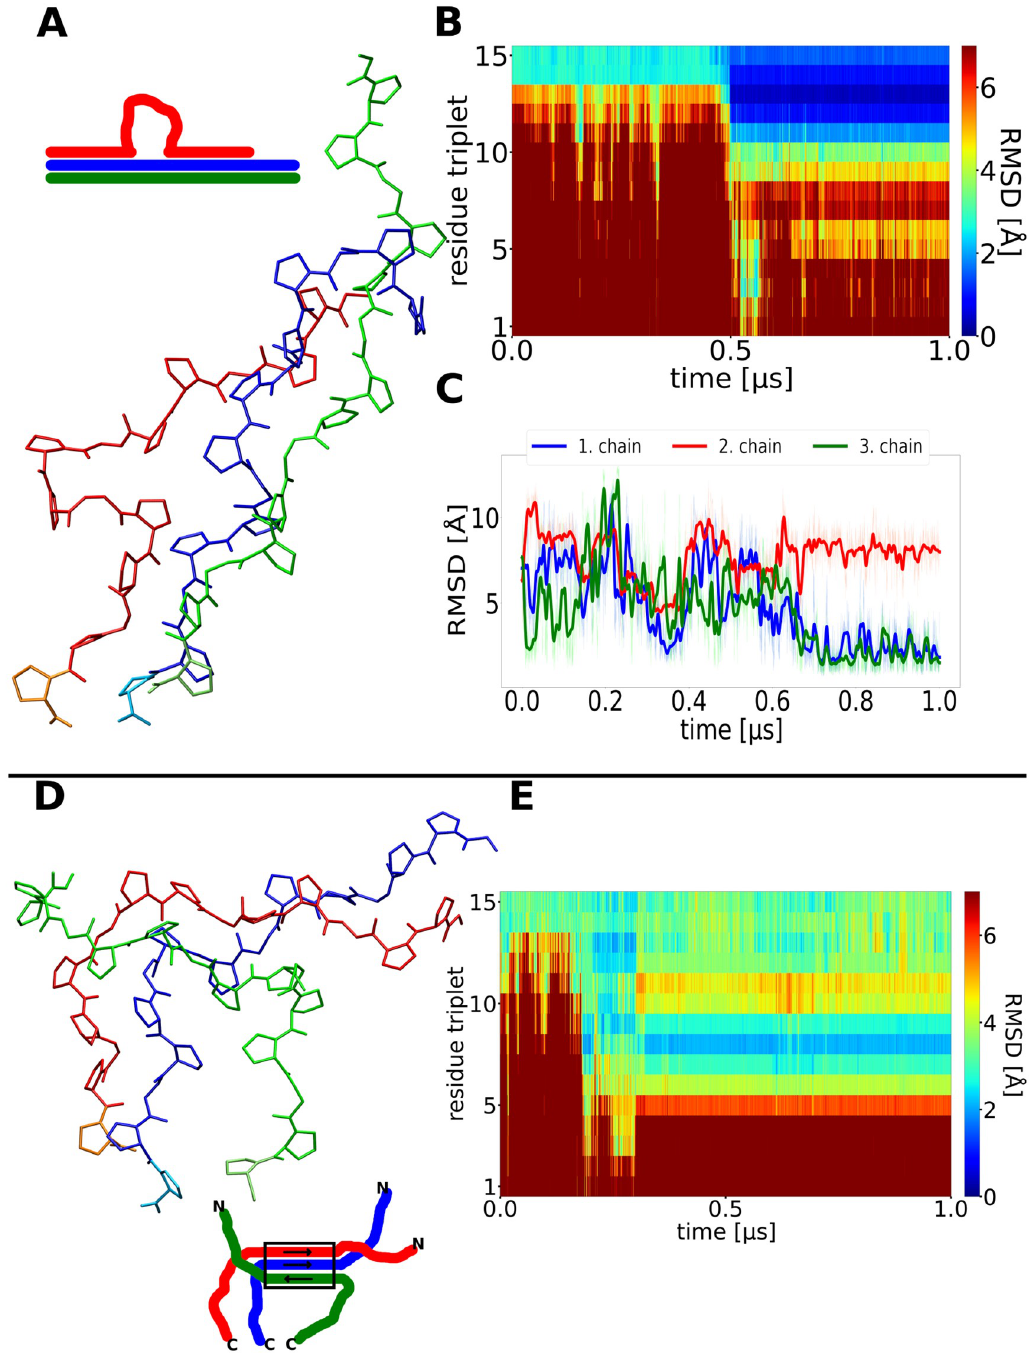
Fig 6. Misfolding of collagen triple helices during simulations (A) Snapshot of a finally sampled conformation with one chain (red) forming a loop but near-native conformation of the neighboring segments observed in a simulation that did not reach the native fold. (B) Time evolution of the RMSD of triplets along the simulation, after 0.5 μ s a correct folding of a first segment up to the loop is observed (blue regime in the plot). (C) RMSD with respect to the native folded triple helix of each chain vs. simulation time. (D) Snapshot at the final stage of a simulation with very weak restraints to stabilize the initial folding nucleus at the C- terminus of the triple helix. The green chain has detached from the other chains at the C-terminus and binds to the other two chains in a non-native arrangement. (E) The non-native arrangement remains stable for the rest of the simulation (after ~0.4 μ s).